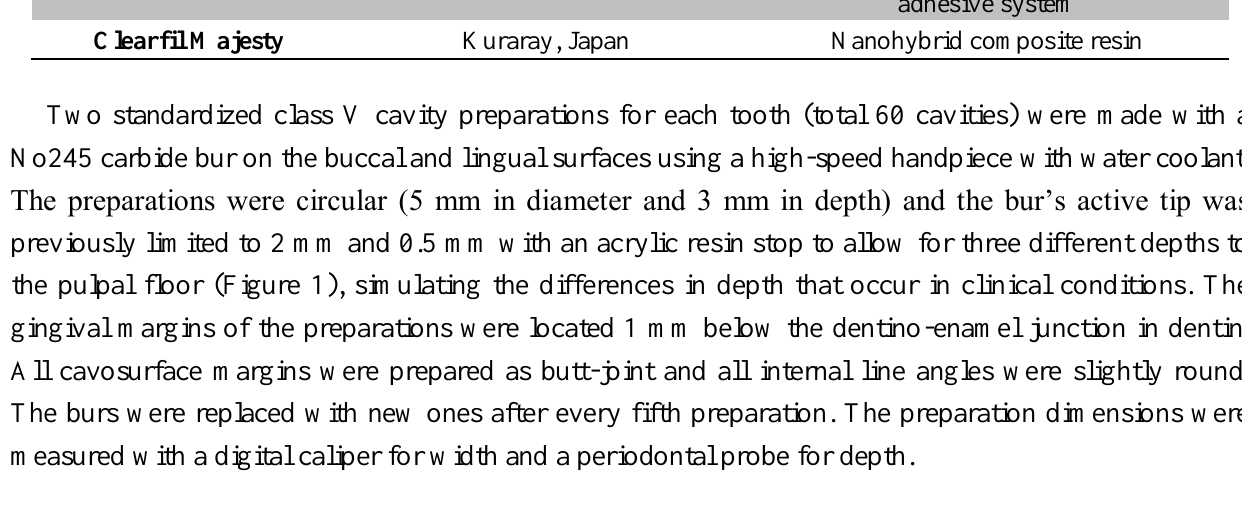
Figure 1. The dimensions of the Class V cavity